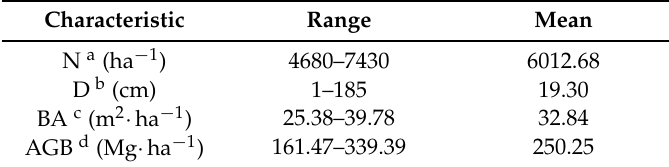
Table 1. Characteristics of 1-ha field plots.